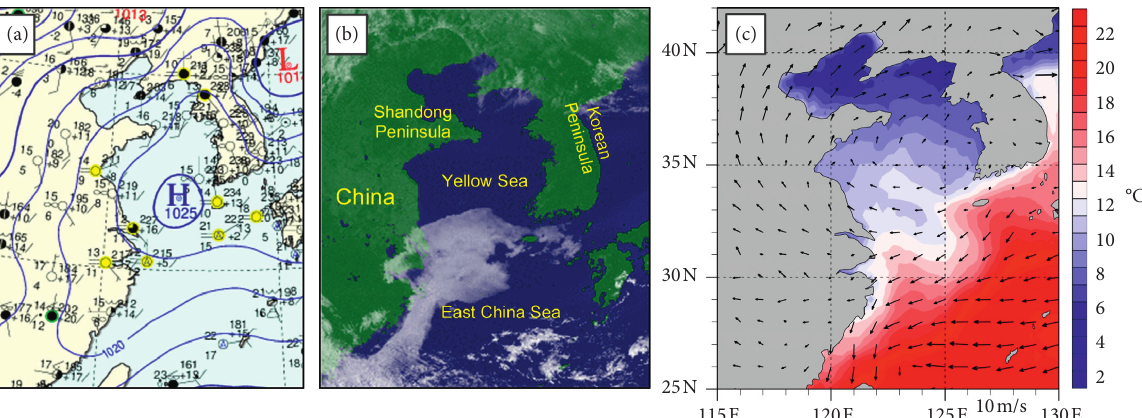
Figure 3: Korea Meteorological Administration (KMA) surface synoptic chart (a), Multifunctional Transport Satellite (MTSAT) visible image (b), and 10m wind vectors over the sea and SST (c) at 00UTC, 10 April